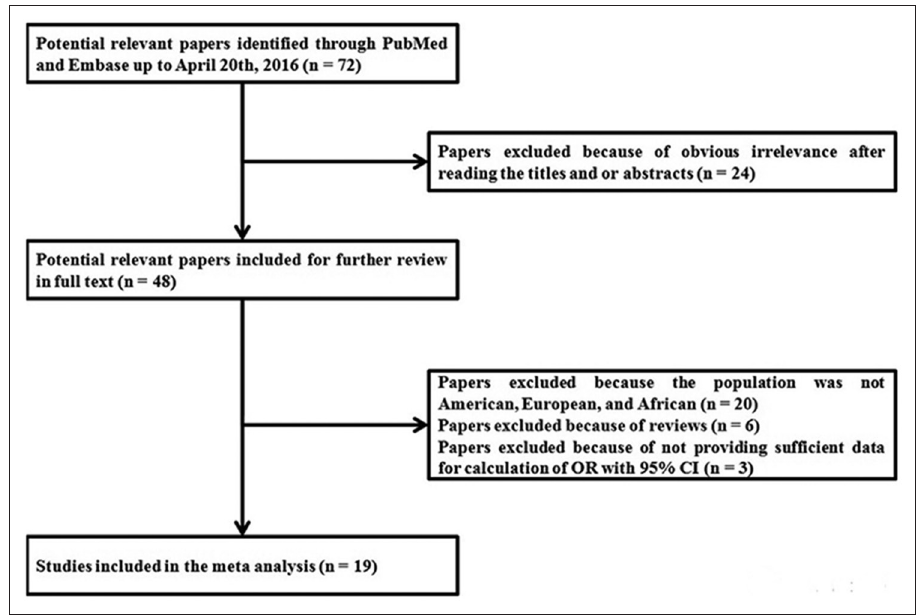
FIGURE 1. Selection of articles for inclusion in the meta‑analysis